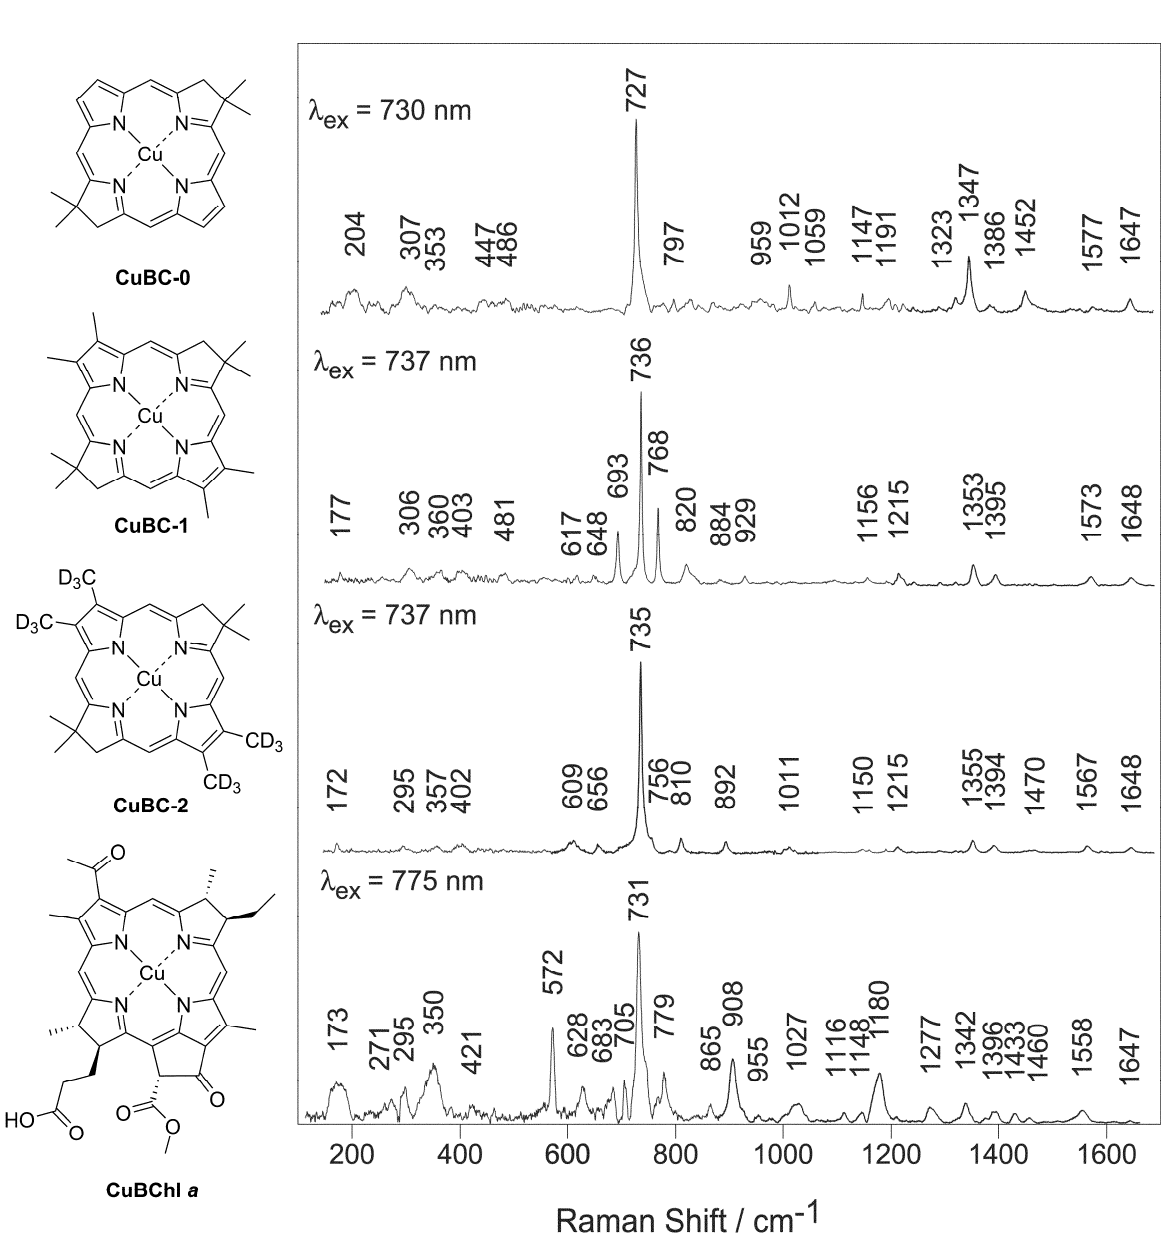
Figure 4. Low- and mid-frequency regions of the Q y -excitation RR spectra of CuBC-0 (CH 2 Cl 2 ) and CuBC-1 (benzene), CuBC-2 (benzene) and CuBChl a (CH 2 Cl 2 ). Thus, the RR studies of CuBC-1 and CuBC-2 reveal that addition of the four beta- pyrrolic substituents increases the number of vibronically coupled modes only modestly and falls short of the vibronic complexity observed for CuBChl a . The increased vi- bronic activity exhibited by the natural pigments and CuBChl a must arise from the increased structural complexity of the macrocycle. In this regard, BChl a is equipped with 2,12-dimethyl substituents, a 3-acetyl group, the isocyclic ring that bridges the 13–15 positions, as well as trans -dialkyl substituents in each pyrroline ring, whereas synthetic bacteriochlorins BC-1 or BC-2 (and metal chelates) contain at the β -pyrrolic sites only the four methyl or four perdeuteriomethyl groups,